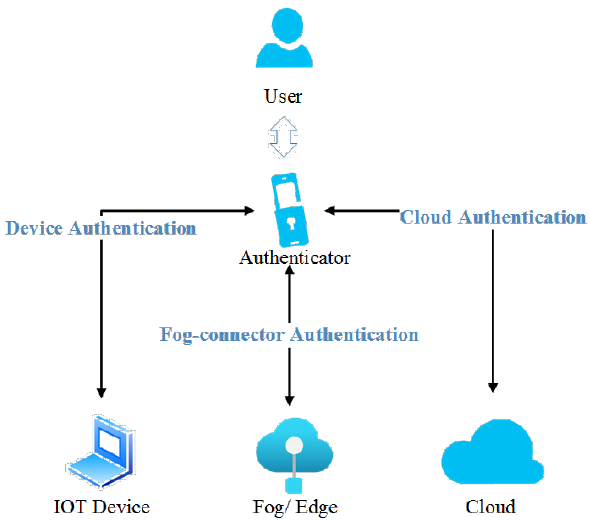
Figure 18. A generic IoT authentication